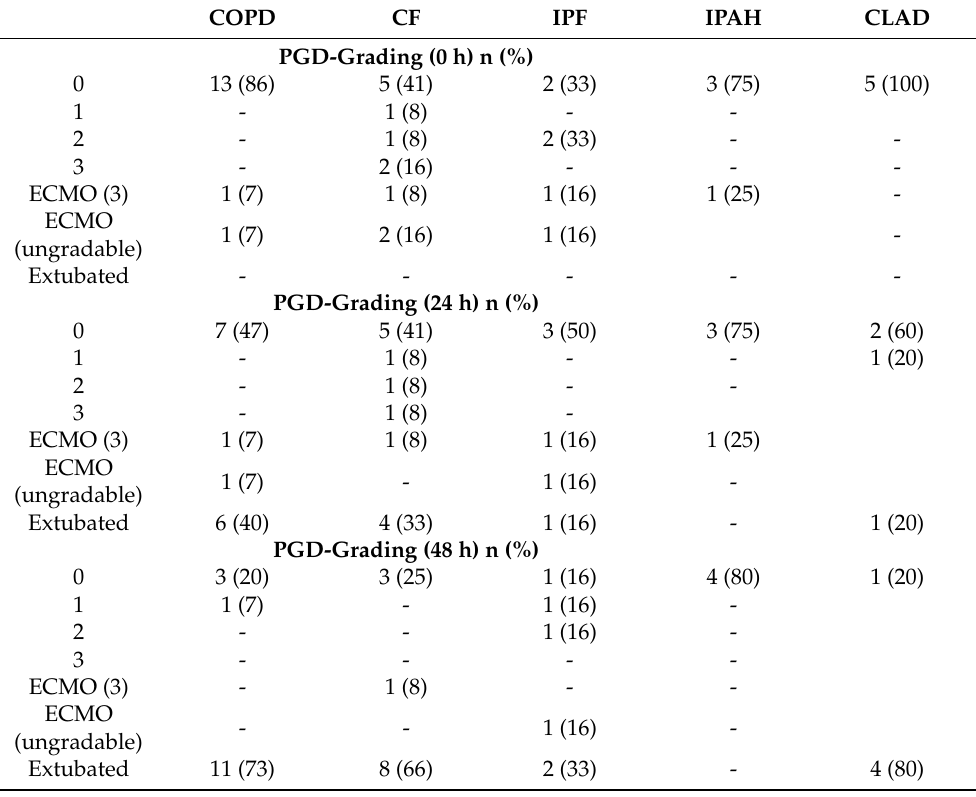
Table 2. Grading of primary graft dysfunction. PGD grading according to the ISHLT consensus definition of 2017 at 0 h, 24 h, 48 h, and 72 h after surgery. PGD on postoperative ECMO support was graded 3 when pulmonary infiltrates on chest X-ray were present; without pulmonary infiltrates it was termed